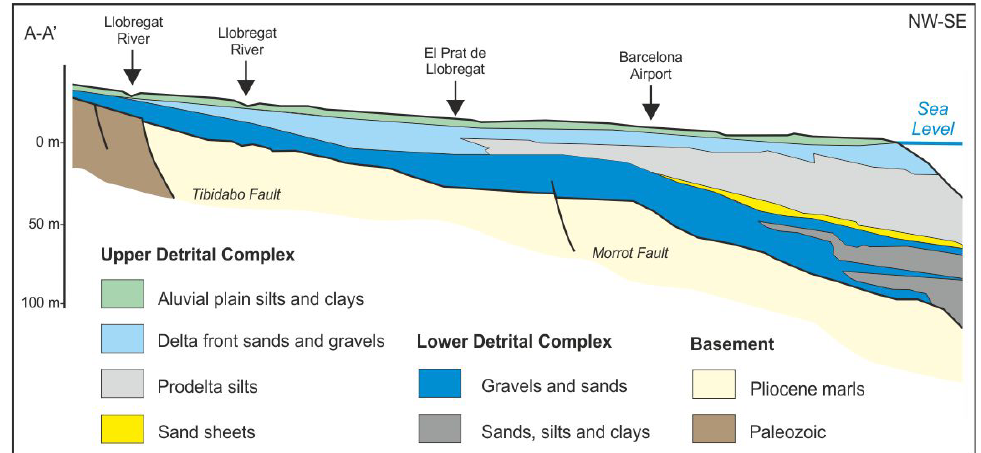
Figure 2. Geological sketch cross-section A-A’ (NW-SE oriented) of the LRD located in Figure 1, modified and simplified from Medialdea and Solé-Sabarís [17,18], Marqués [30] and Simó et al. [39].